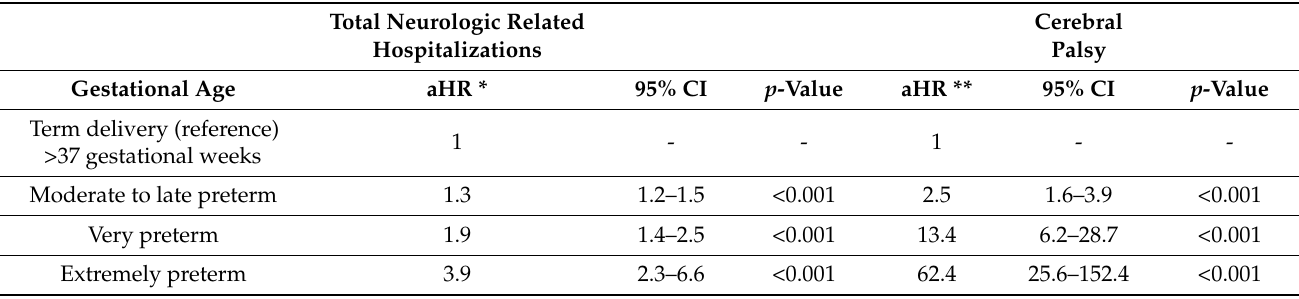
Table 3. Cox multivariable analyses for long-term neurologic-related hospitalizations and for CP according to gestational age.